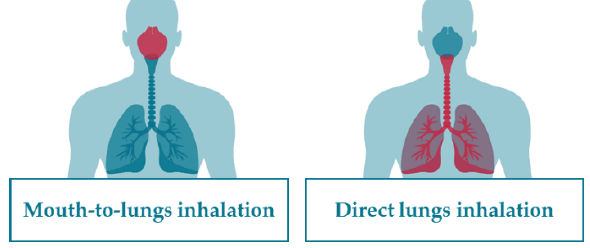
Figure 3. Mouth to lungs and direct lungs inhalations.